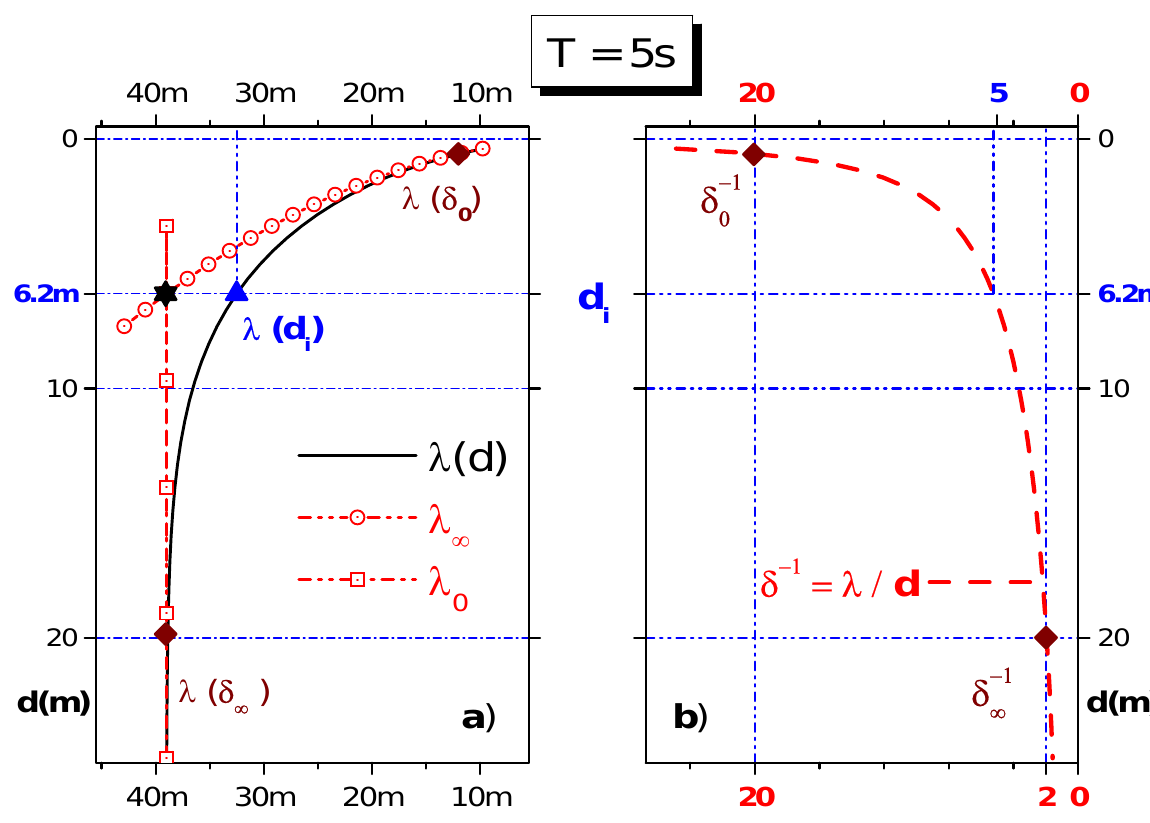
Figure 1. for a wave with period T = 5 sT = 5 sT = 5 s , the panel a) shows the behavior of the wavelengths λλλ and λ 0 λ 0 λ 0 as a function of the depth ddd and the deep water wavelength λ ∞ λ ∞ λ ∞ . It is also noted that λ 0 = λ ∞ λ 0 = λ ∞ λ 0 = λ ∞ at depth d i d i d i . The panel b) shows that in shallow waters λ / d i ≈ 5 λ / d i ≈ 5 λ / d i ≈ 5 is limited between δ – 1 0 δ – 1 0 δ – 1 0 and δ – 1 ∞ δ – 1 ∞ δ – 1 ∞ , these results are in accordance with those pioneering discussed in (Lighthill